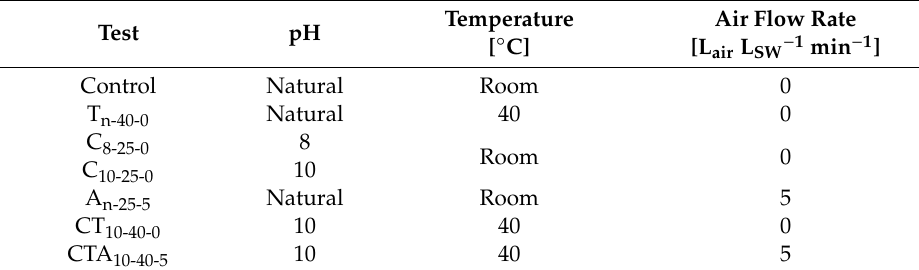
Table 1. Experimental design of the tests on SW and related operational